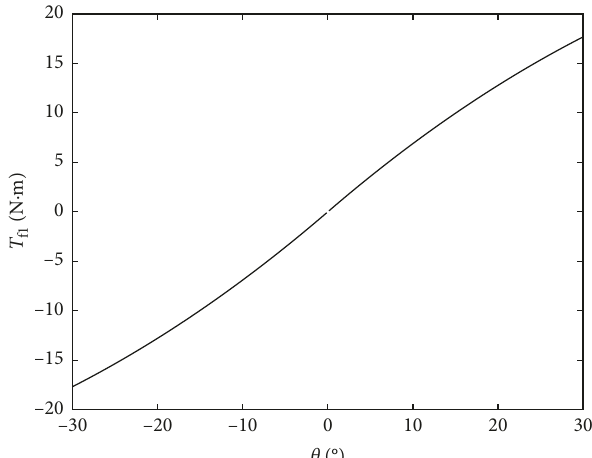
Figure 5: The relationship curve of frictional torque and torsion angle.